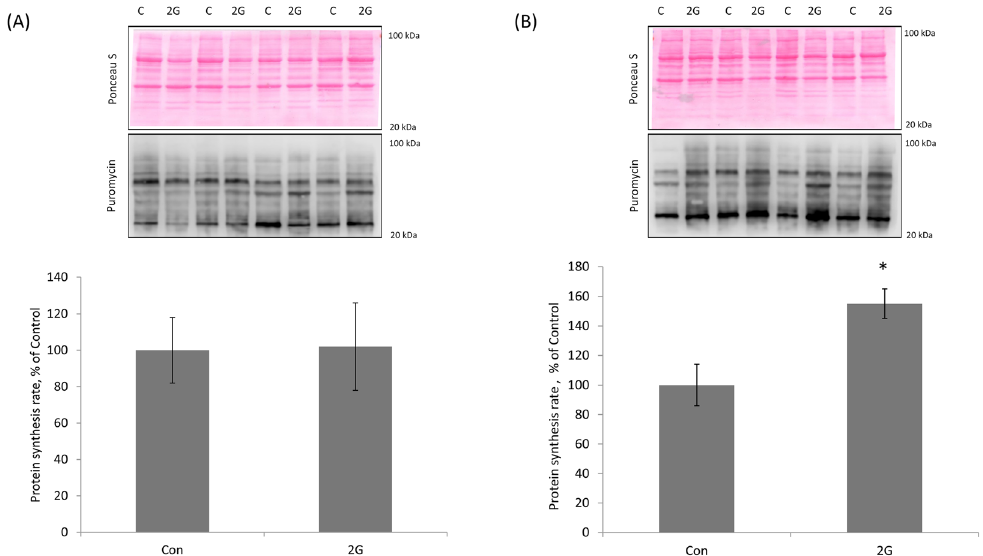
Figure 1. The rate of protein synthesis in murine Sol ( A ) and TA ( B ) muscles following 30-day 2G centrifugation. Quantification of the puromycin-labeled peptides is expressed as a percentage of the values obtained in the control group. Representative WB images for puromycin and Ponceau S staining to verify equal loading of proteins are shown above the graphs. Con – control mice, 2G – mice exposed to 30-day 2G centrifugation. * Significant difference from control (p < 0.05). All values are means ± SE, n =